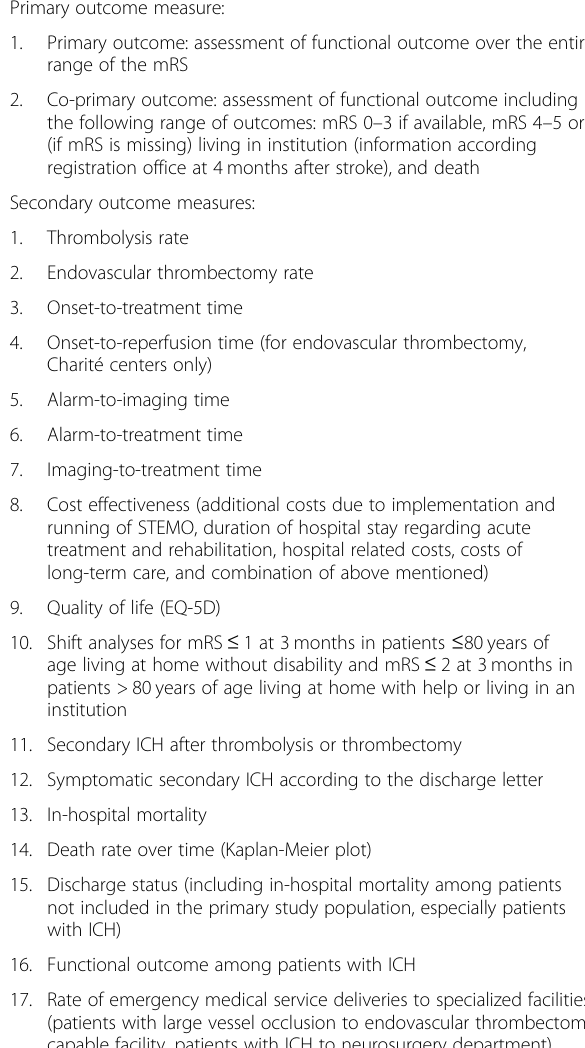
Table 2 Outcome